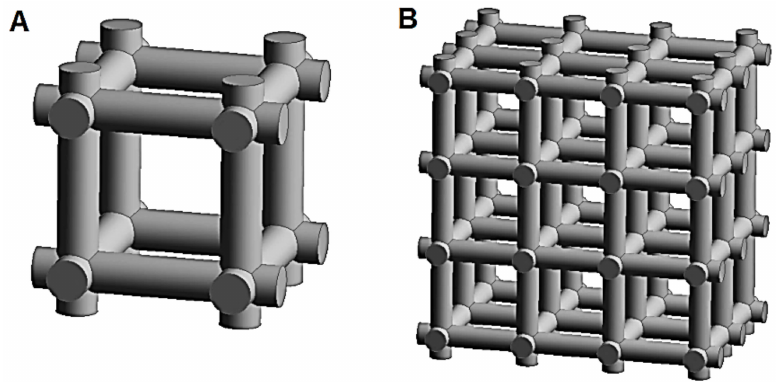
Figure 5. Single cubic cell ( A ); combined cubic cells ( B ).